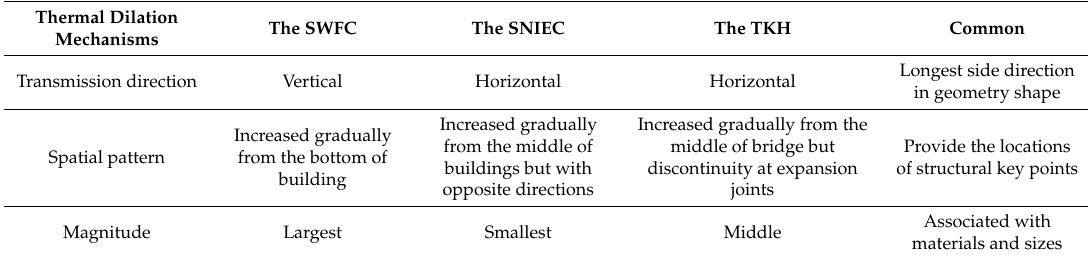
Table 3. The thermal dilation mechanisms for civil